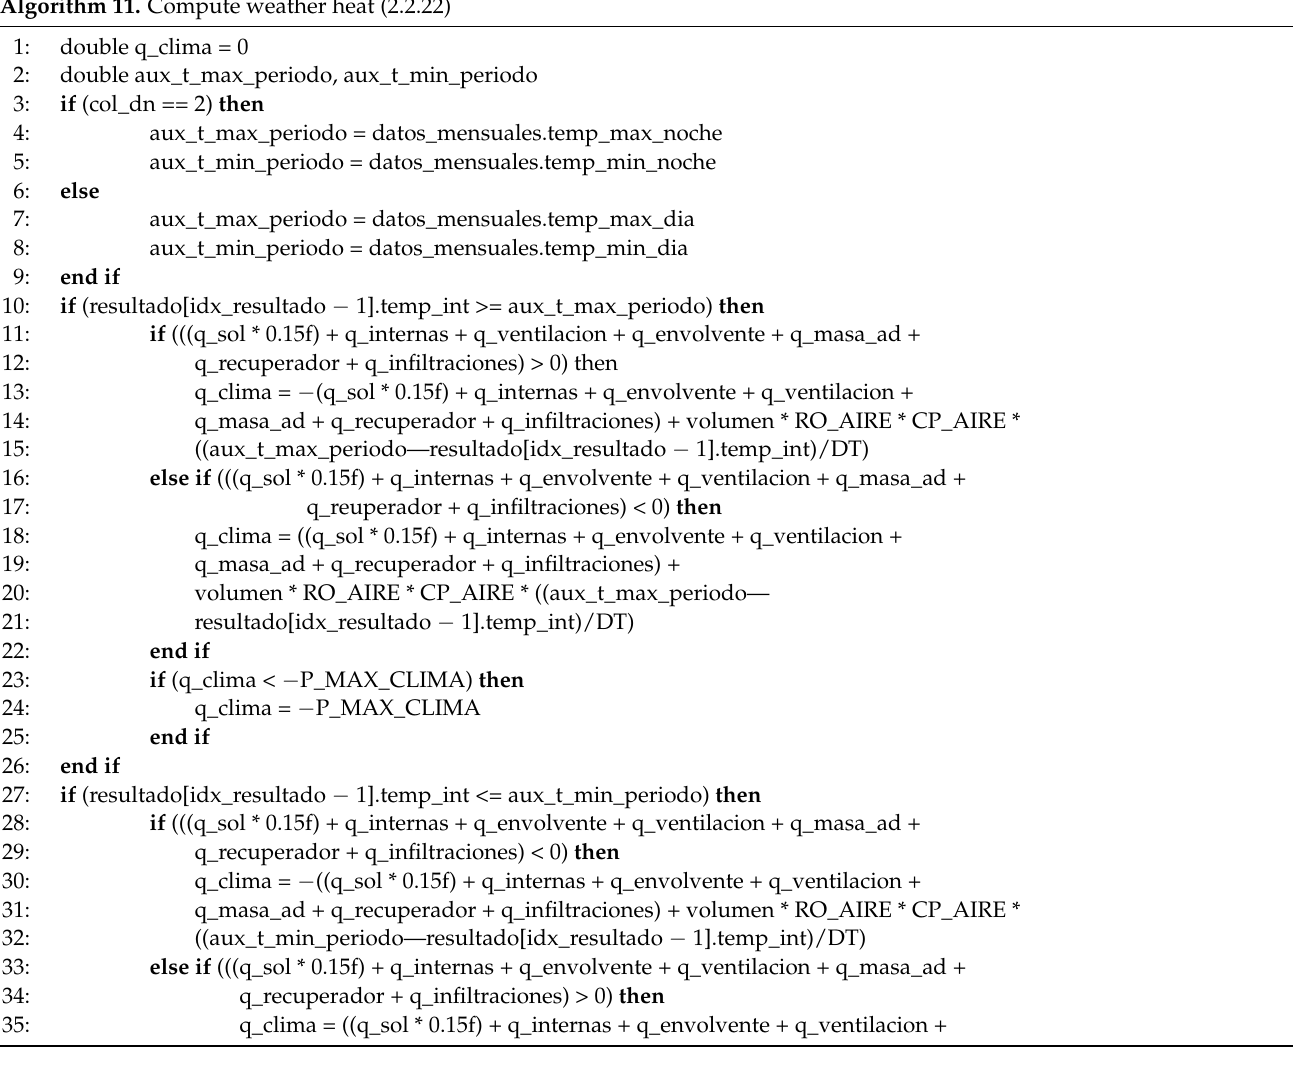
Algorithm 11 calculates the interior heat of the house in response to weather events. Heat can be added or removed from the structure based on the behaviour of meteorological factors using the monthly data stored by the system. Algorithm 11. Compute weather heat